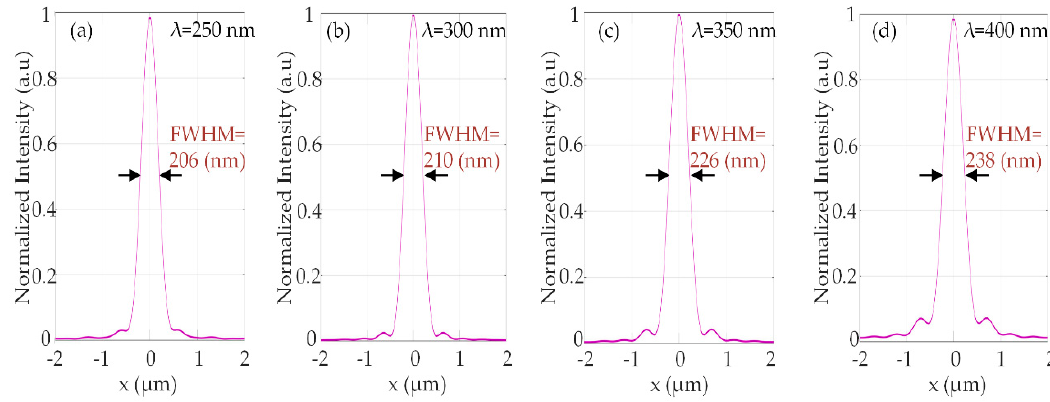
Figure 4. Normalized intensity profiles of the focus spot along x-direction at respective wavelengths (a) y = 0, λ = 250 nm, z = 5.3 µm, (b) y = 0, λ = 300 nm, z = 4.4 µm, (c) y = 0, λ = 350 nm, z = 3.5 µm and (d) y = 0, λ = 400 nm, z = 2.9 µm.